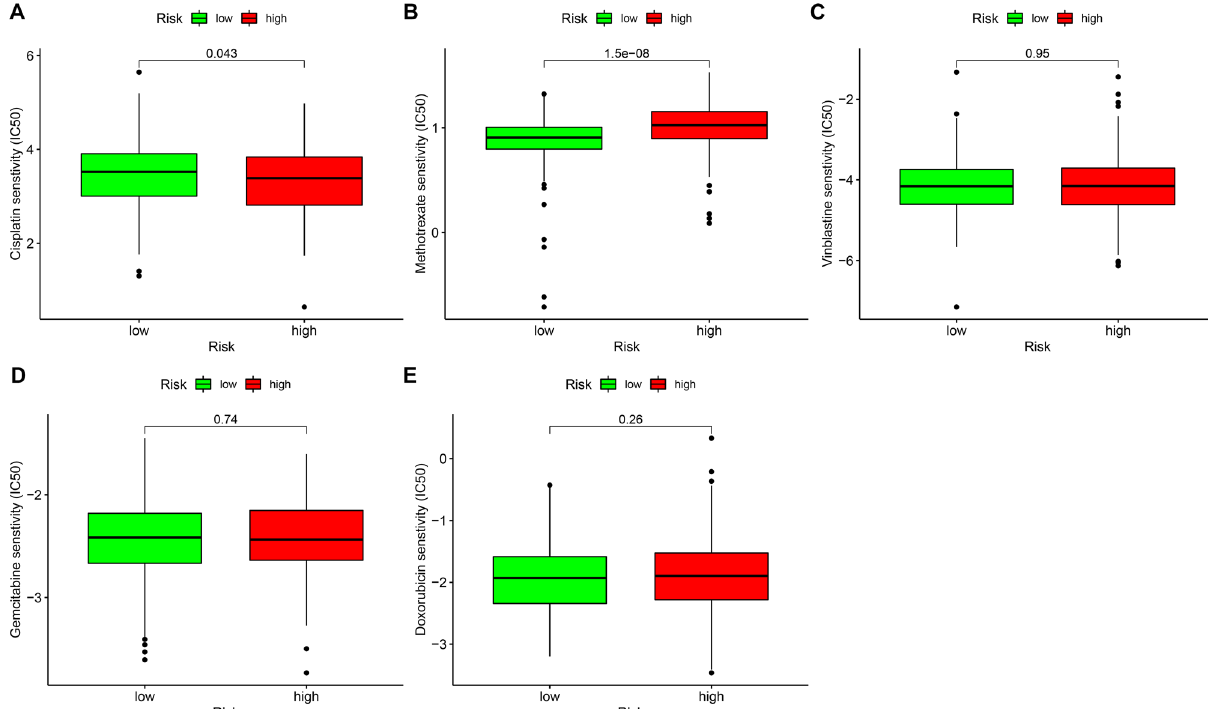
Figure 8. Correlations between risk model and the sensitivity to chemotherapy drugs in bladder cancer. Comparing the IC50 values of ( A ) cisplatin; ( B ) methotrexate; ( C ) vinblastine; ( D ) gemcitabine and ( E ) doxorubicin in high and low bladder cancer